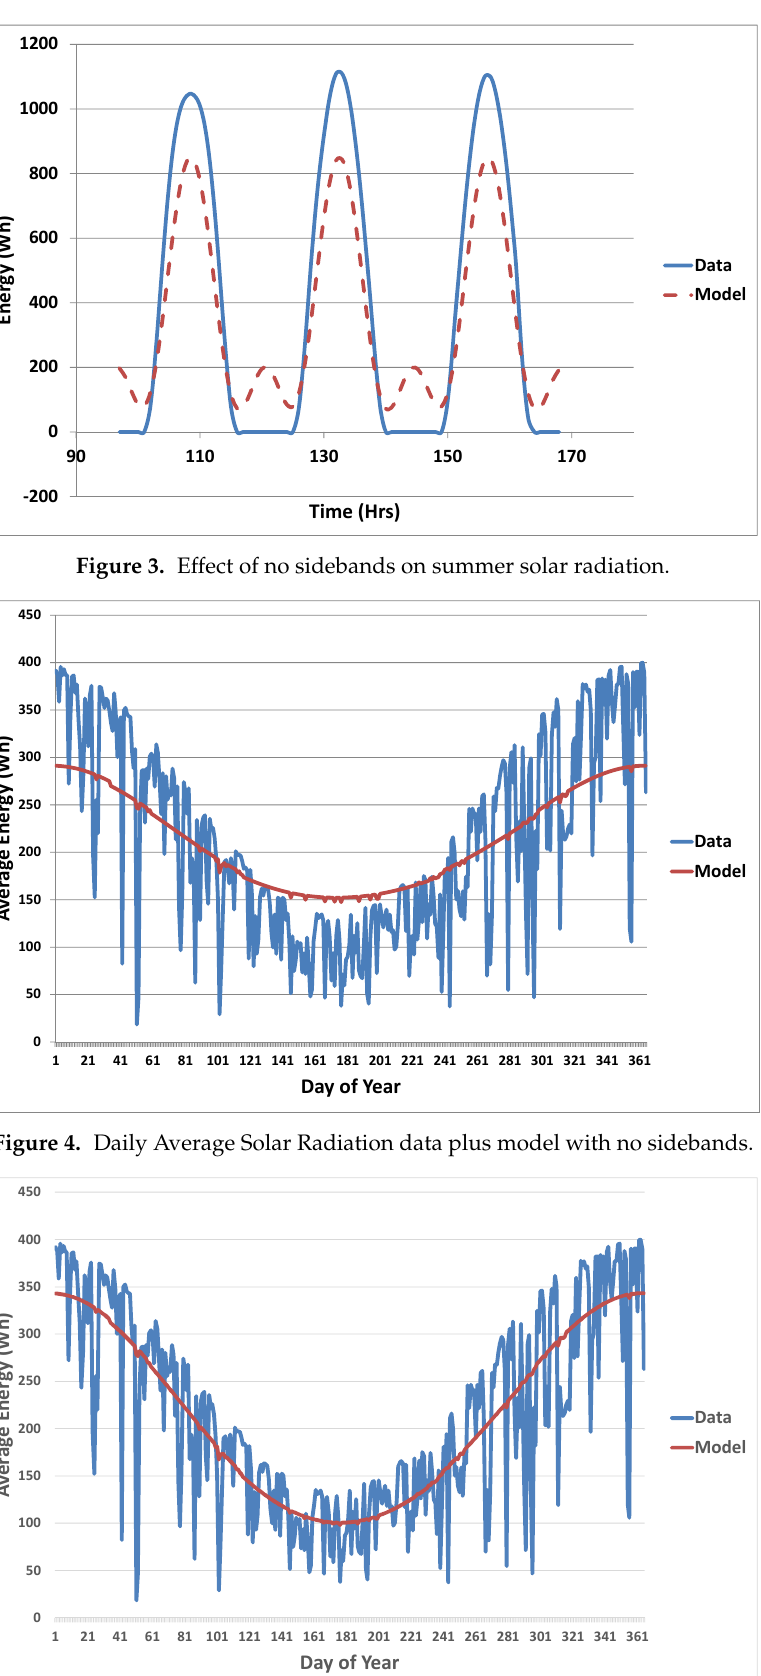
Figure 5. Daily Average Solar Radiation data plus model with sidebands